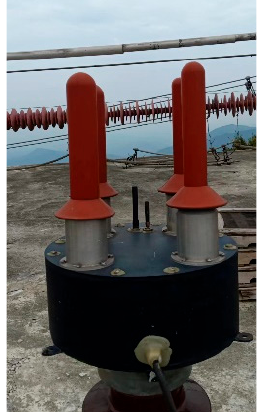
Figure 15. The ice accretor in Hunan Xuefengshan Energy Equipment Safety National Observation and Research Station.